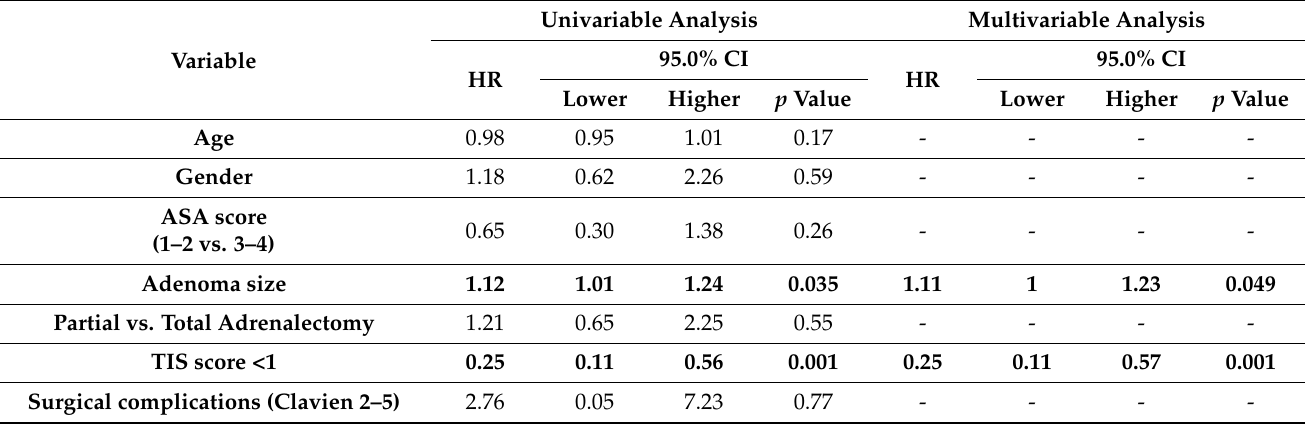
Table 4. Univariable and multivariable Cox regression analysis to identify predictors of complete clinical success.